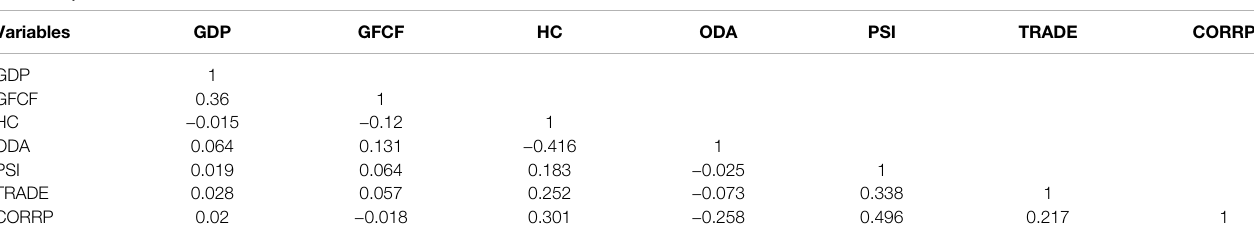
TABLE 3 | Correlation matrix. Variables